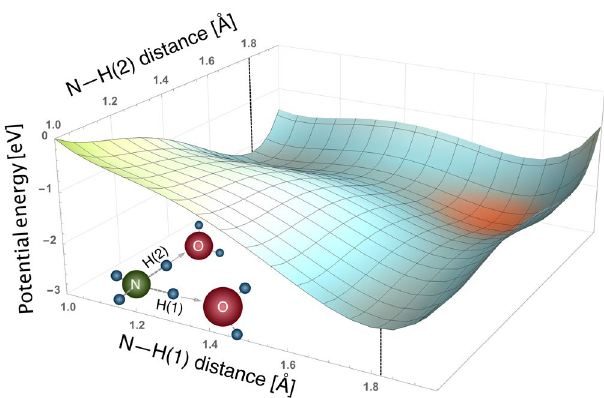
Figure 2. Unrelaxed two-dimensional cut through the potential-energy surface of a core-ionized + NH (H O) cluster showing the electronic energy as a function of the N—H distances along the direction of two hydrogen bonds. The N—H ground state distance is 1.1 Å. The minimum energy corresponding to the fully transferred proton is at ~1.8 Å, marked by black dashed lines. Note that the third water molecule in the molecular sketch is omitted for